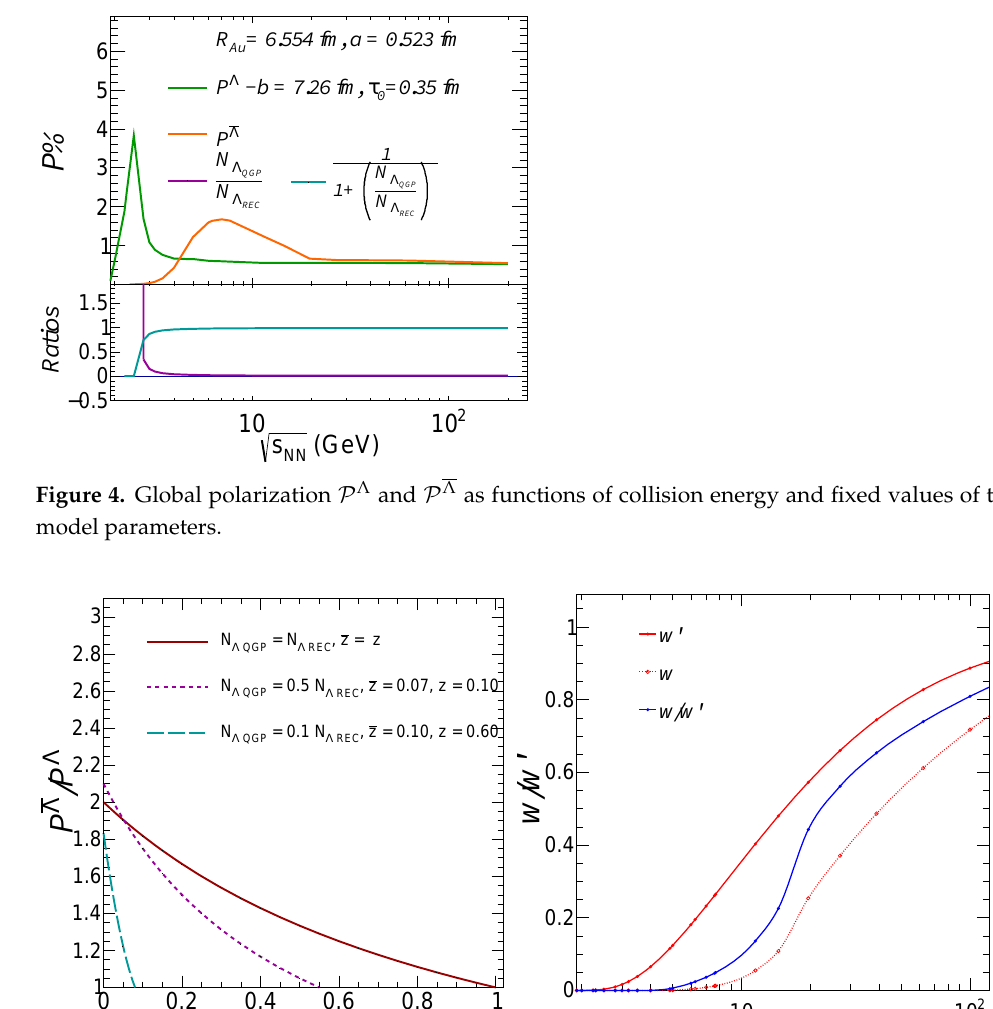
< 1, even though ¯ z < z . / N Λ QGP REC